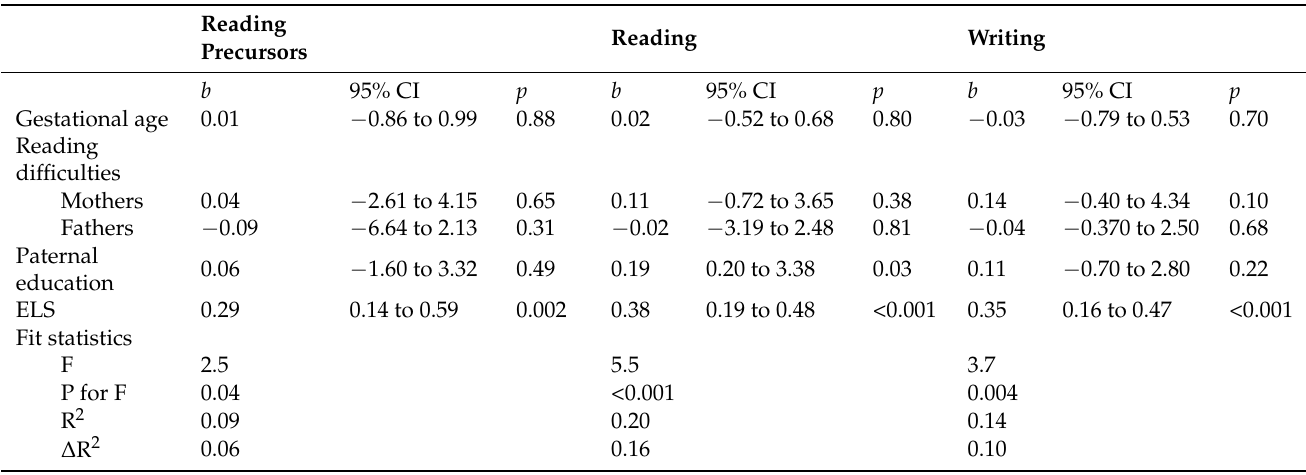
Table A3. Results of multiple variable linear regression analysis with reading precursors, reading, and writing skills at 7 years of age as dependent variables, and with ELS at 2 years of age and background factors as independent variables. Results of full-term controls are